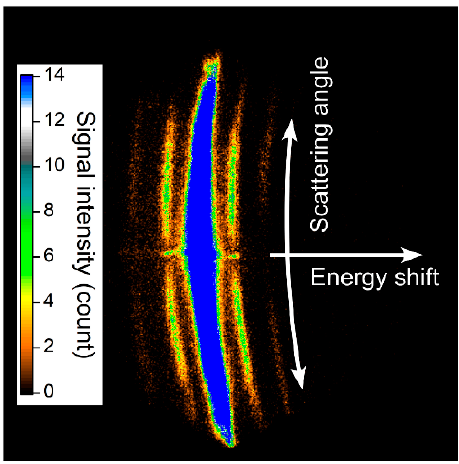
Figure 6. A raw image of the scattered electrons recorded when 1 keV electrons were scattered by Xe atoms in an intense laser field ( λ = 800 nm, I = 1.5 × 10 12 W/cm 2 , Δ t = 970 fs) [10].